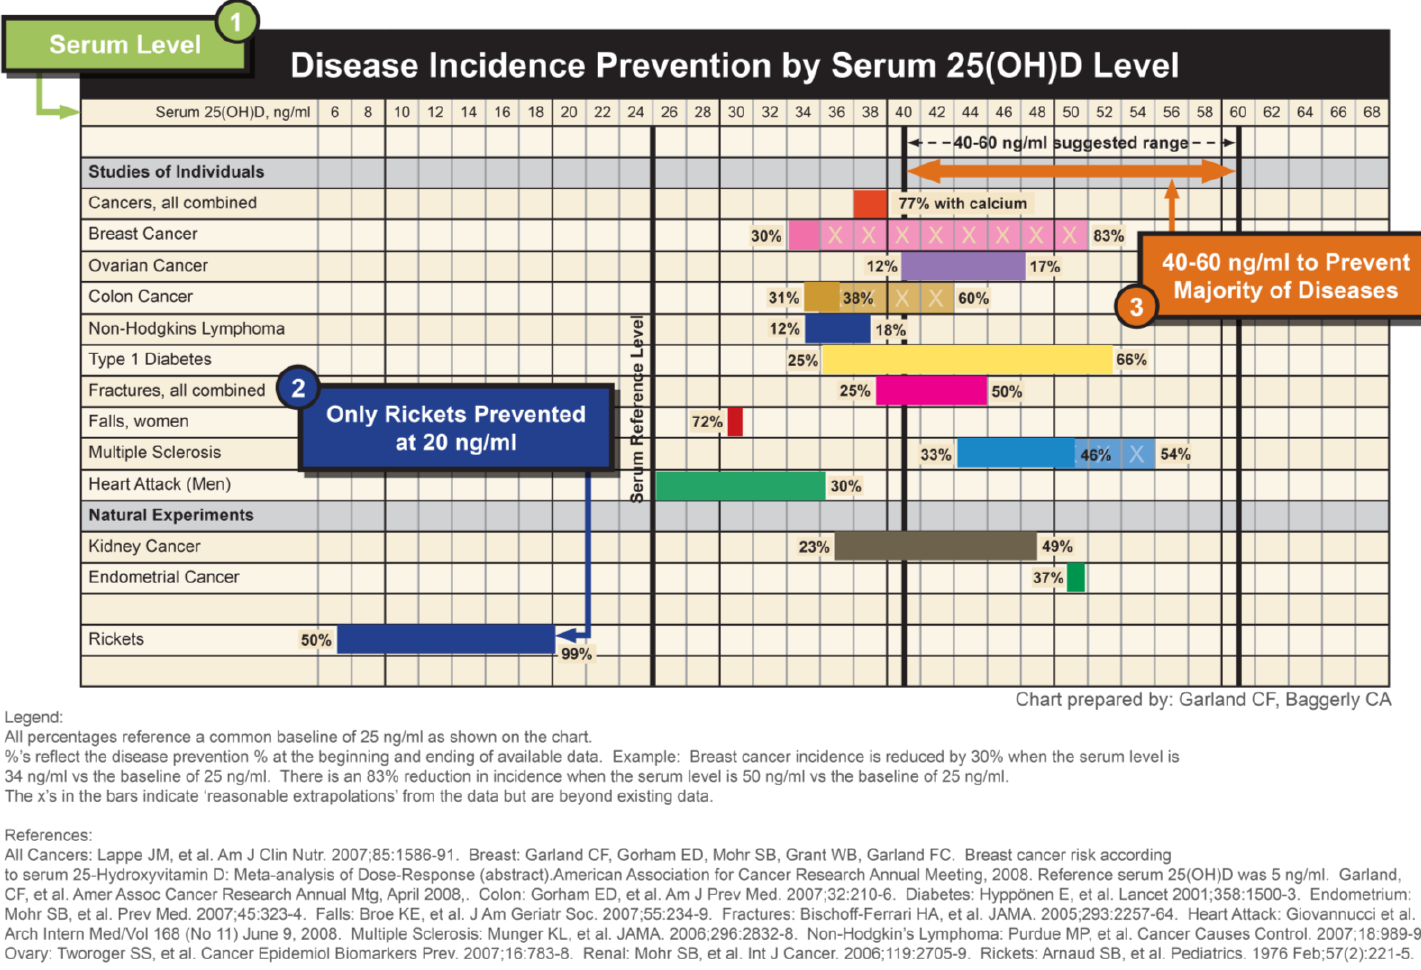
Figure 2. Disease Incidence Prevention by serum 25(OH)D levels. [18] (Used with